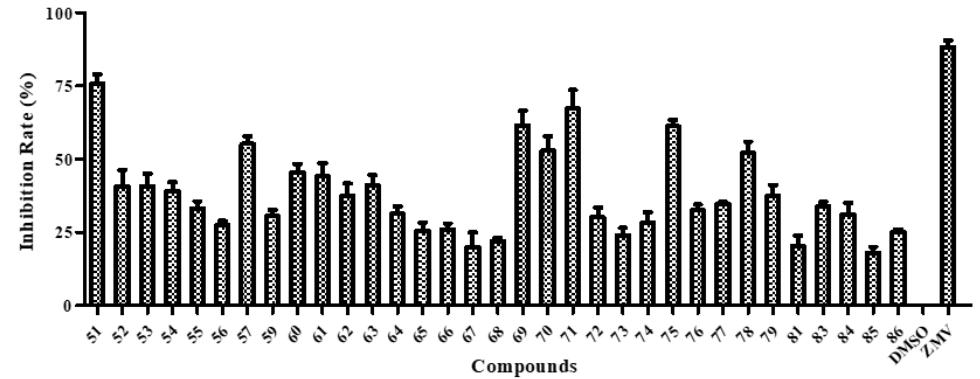
Figure 3. CPE-based screening of BA-CD conjugates 51 – 57 , 59 – 79 , 81 and 83 – 86 at a single concentration (20 μ M). DMSO (1%) and zanamivir (ZMV, 5 μ M) were used as negative and positive controls, respectively. Error bars indicate standard deviations of measurements of triplicate samples. Table 1. In vitro cytotoxicity and anti-influenza activity of BA and its CD conjugates.